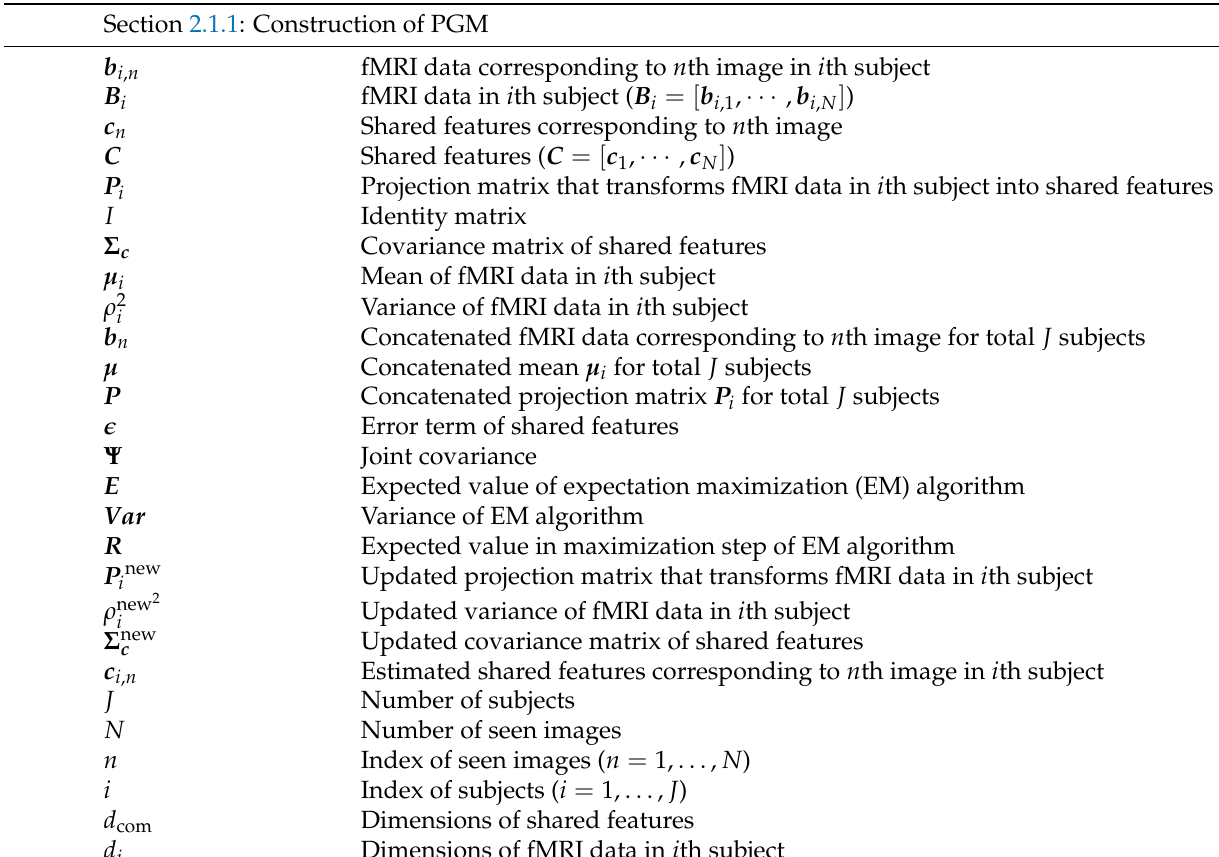
Table A1. List of variables used for the proposed method in the training and test phases corresponds to Sections 2.1 and